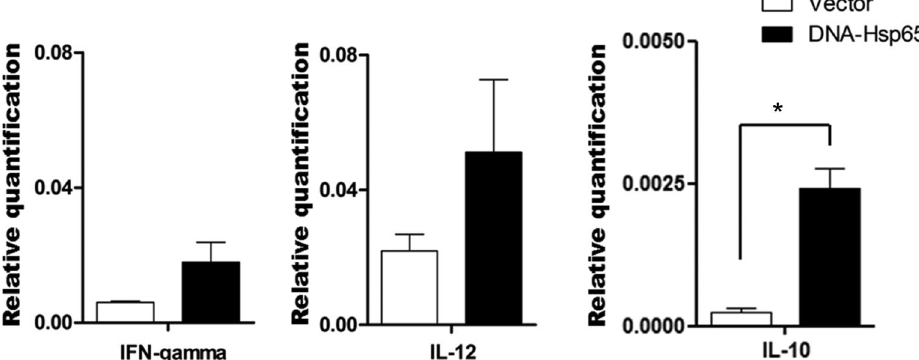
Figure 3. Relative expression of cytokine mRNAs in puri fi ed B cells from wild-type (WT) mouse spleens 30 days after immunization. C57BL/6 WT mice were injected intramuscularly on three occasions, at 15-day intervals, with 100 m g pcDNA3 encoding Mycobacterium leprae 65-kDa heat-shock protein (DNA-Hsp65 group) or with 100 m g empty pcDNA3 as a control (Vector group). Thirty days after the last immunization, the B cells were puri fi ed from the spleens of WT mice with magnetic beads, using an anti-CD43 monoclonal antibody (negative selection). Gene pro fi les of A , IFN- g , B , IL-12, and C , IL-10 in B cells (CD43 – ) were evaluated with real-time qPCR. *P o 0.05 WT immunized with DNA-Hsp65 vs WT immunized with Vector (ANOVA, followed by Tukey ’ s